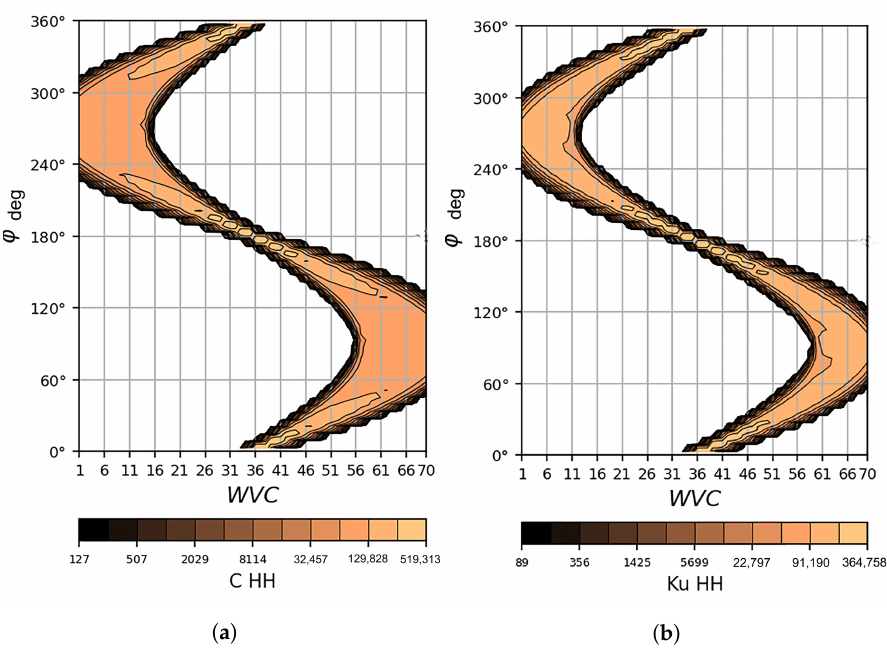
Figure 4. Azimuth angle distribution as a function of WVC: ( a ) C-band HH. ( b ) Ku-band